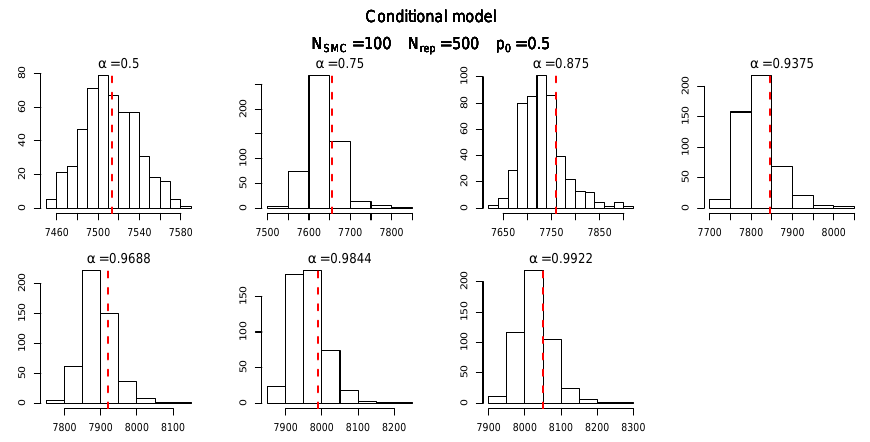
Figure 7. Histograms levels used in the SMC sampler algorithm with p 0 = 0.5 in the marginalized model. The red dashed bar represents the true value of the α quantile.